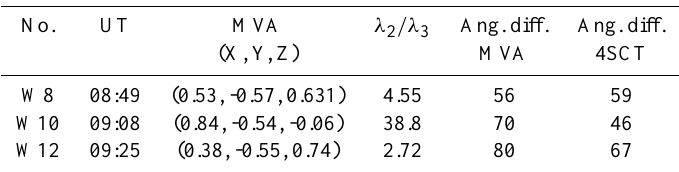
Table 3. The outputs of the minimum variance analysis (MVA) of magnetic field data from the Polar spacecraft at various universal times along with the ratio of the intermediate to minimum eigenvalues. The Ang. Diff. MVA and Ang. Diff. 4SCT columns show the angu- lar difference between the MVA vector at Polar and the MVA vector and four-spacecraft timing vector respectively from Cluster for the corresponding event (nearest in